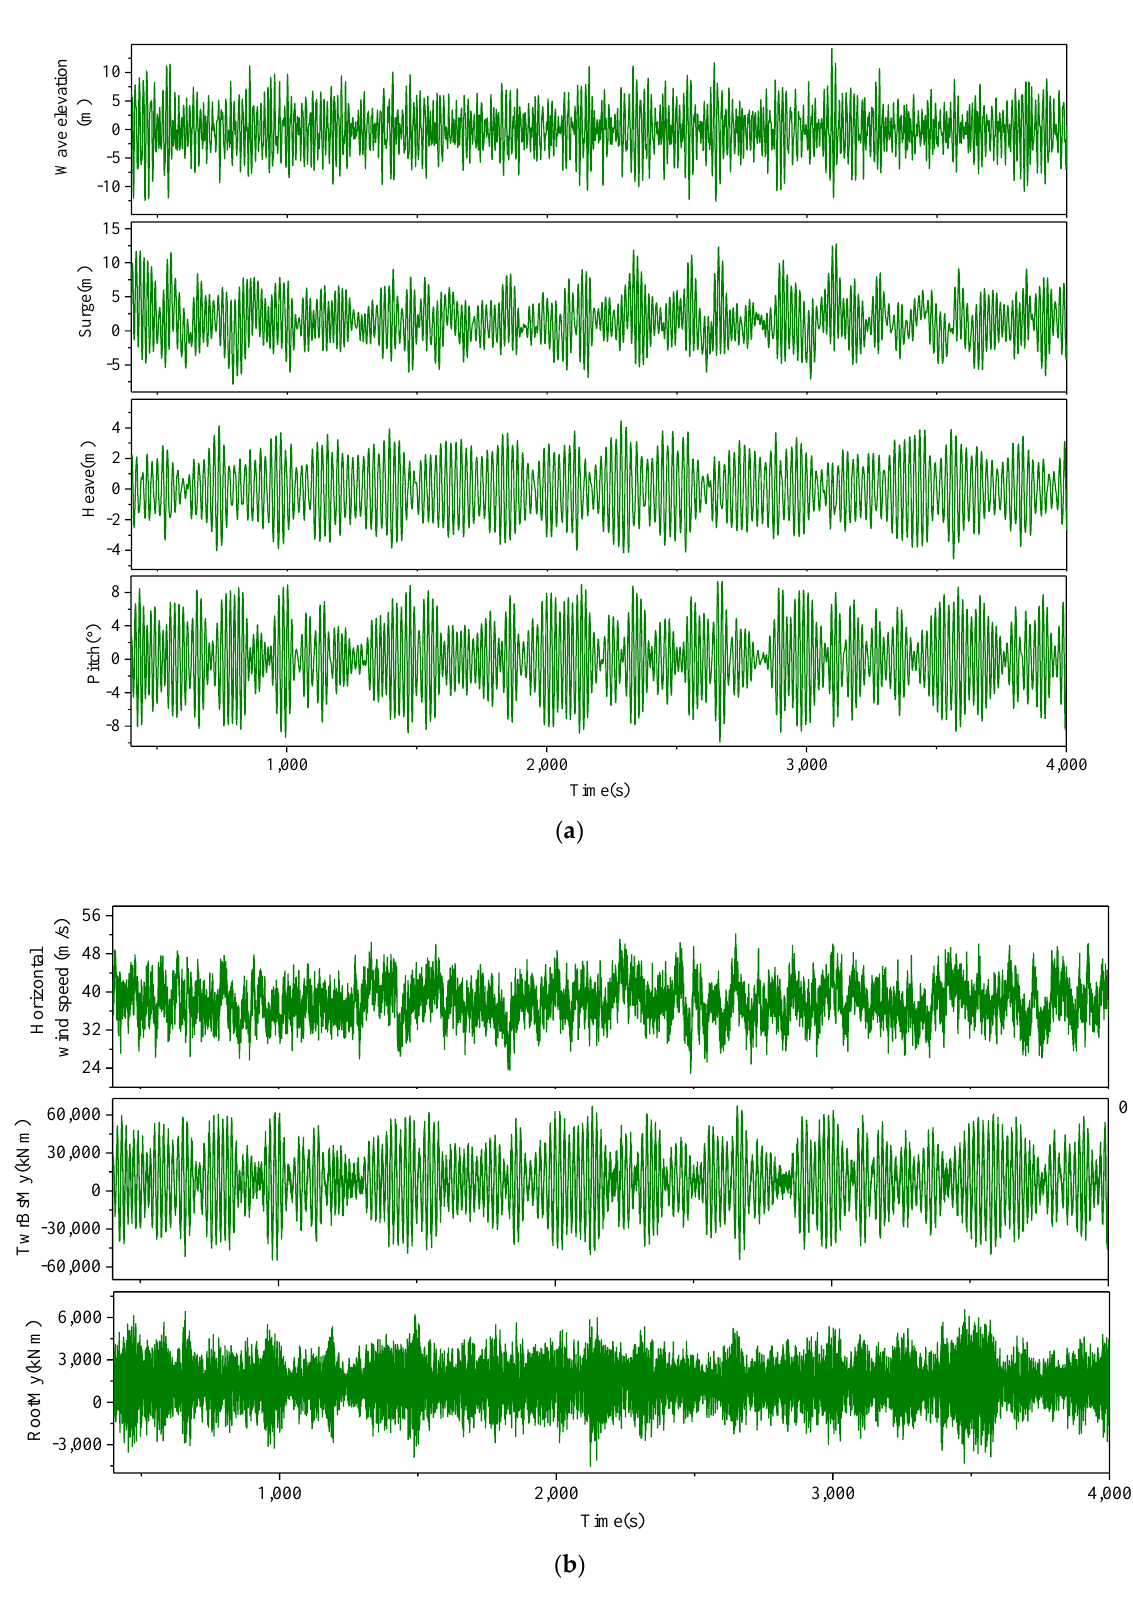
Figure 15. Time histories of responses of the cage and wind turbine under condition 3. ( a ) Cage responses. ( b ) Wind turbine responses.